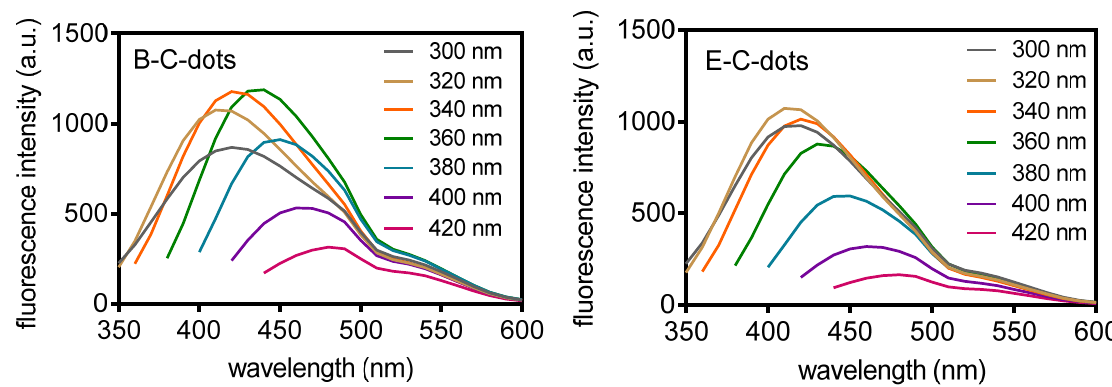
Figure 3. Fluorescence emission spectra of hydrothermally derived C-dots from B. breve ATCC 15700 (B-C dots) and E. coli ATCC 25922 (E-C-dots) at different excitation wavelengths (indicated in the panels) in 10 mM phosphate buffer (pH 7.4).